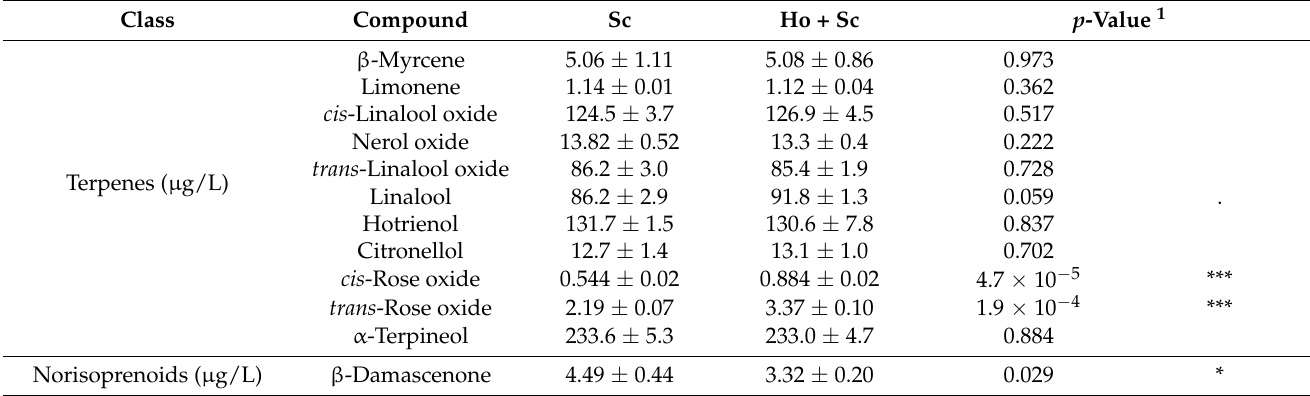
Table 3. Terpene and norisoprenoid composition of the